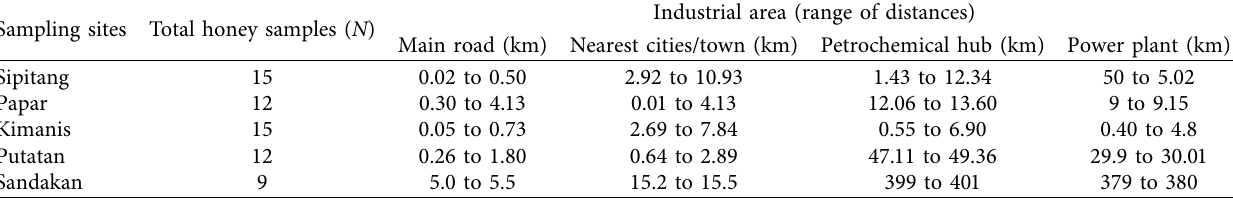
Table 1: Location of honey sampling sites by distance from contamination sources in the Malaysian state of Sabah. Sampling sites Total honey samples ( N )